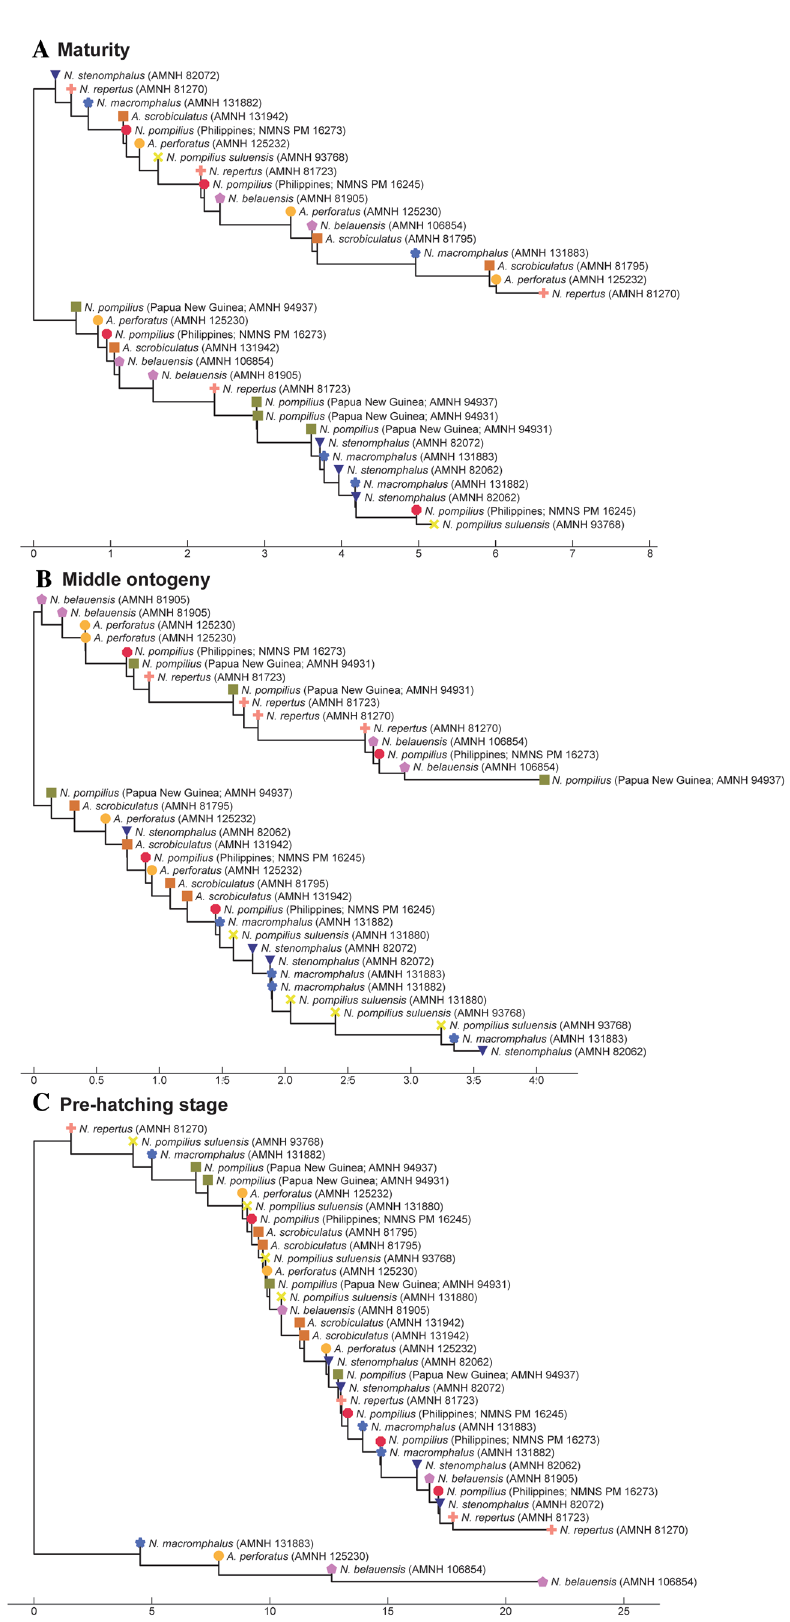
Figure 6. Trees for septal spacing. ( A ) Maturity (last two chambers. ( B ) Middle ontogeny (a diameter of about 50 mm). ( C ) Pre-hatching stage (a diameter of about 20